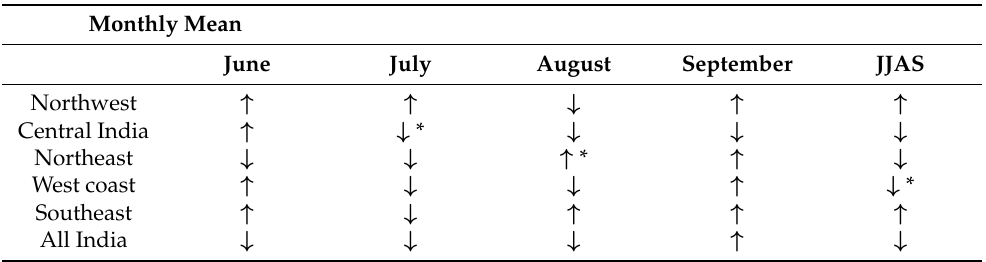
Table 2. Trends in monthly mean rainfall from 1985 to 2018, where “*” shows a significant trend at 95%. The up/down arrows show increasing/decreasing